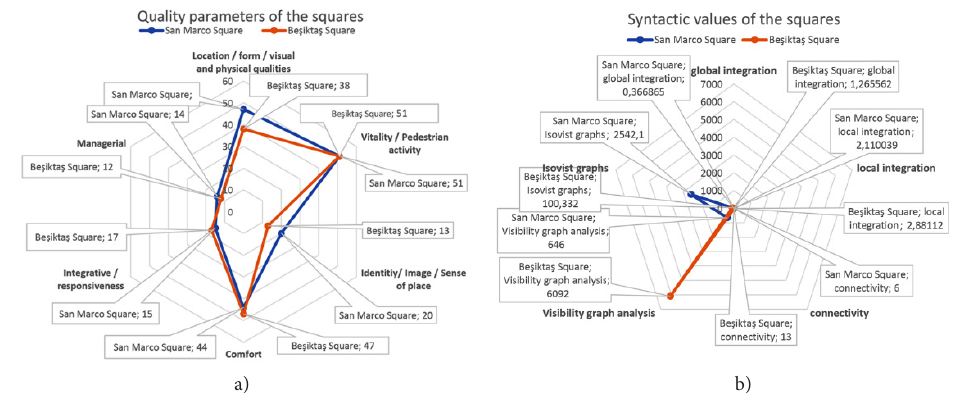
Figure 7. Radar diagram showing quality assessment of the squares according to observation and syntactic